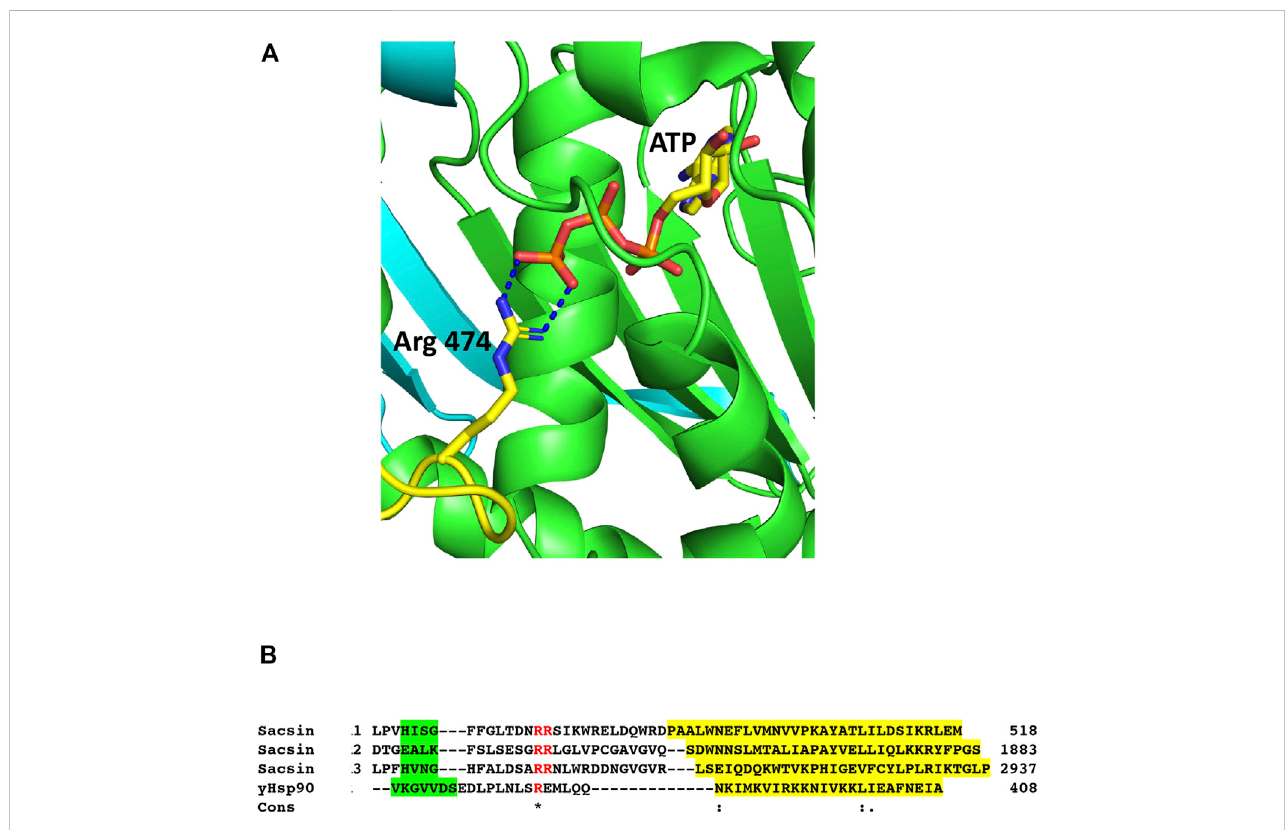
FIGURE 5 The catalytic Arg 474 of sacsin. (A) PyMol cartoon of the potential interaction of Arg 474 (yellow-blue stick molecule) with bound ATP (yellow-red stick molecule) inthe SR1domain (green). (B) Alignment ofthe catalytic loop regions, containing theconserved arginineresidues ofSR1, 2 and 3(Sacsin 1,2 and 3), andtheadjoiningstructuralelementswiththesameregionsasforyeastHsp90(yHsp90).Theconservedarginineresidueandanadjacent arginineresidueare showninred.Structuralelementsarecolourhighlighted:Green, β -strandandyellow, α -helix.Cons,conservation,(.),weaklyconservedresidueposition; (:), strongly conserved residue position and (*), invariant residue